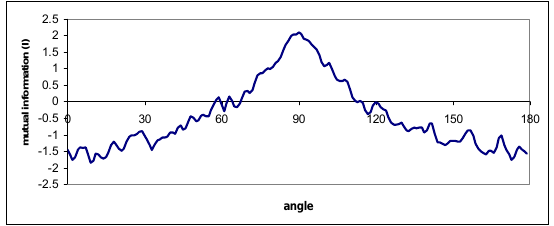
Figure 3. Mutual information for different angles between projected model edges and pixel gradient